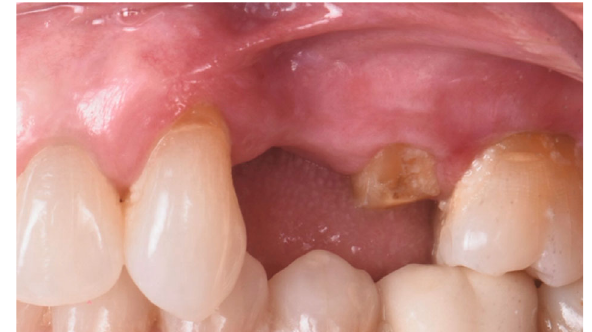
Figure 1: Desquamative erythematous lesion in the vestibular area upper left quadrant.